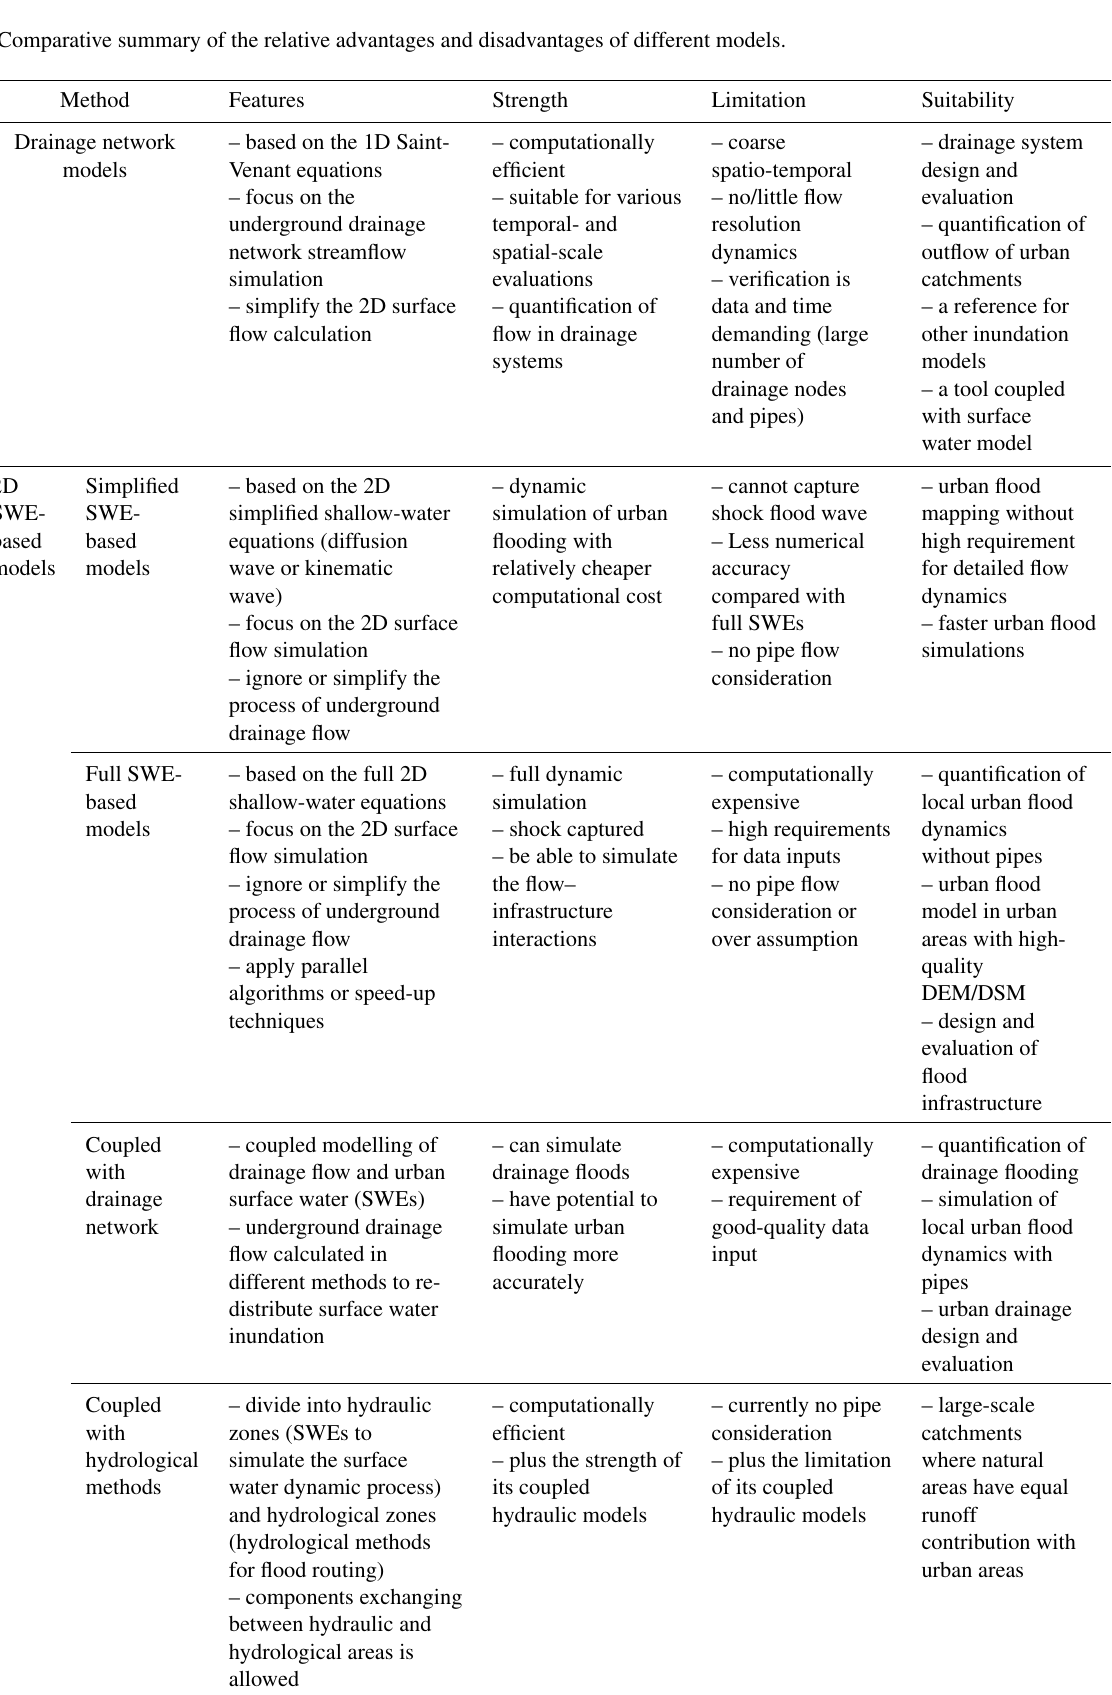
Table 4. Comparative summary of the relative advantages and disadvantages of different